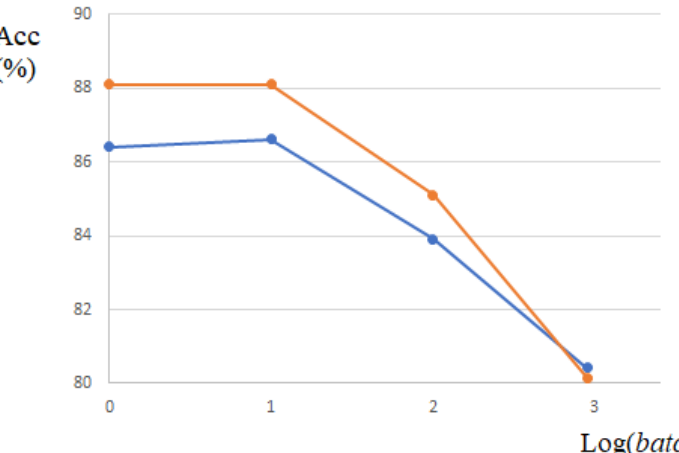
Figure 8. Testing accuracy obtained by different batch sizes, for English ( red ) and Italian ( blue ).